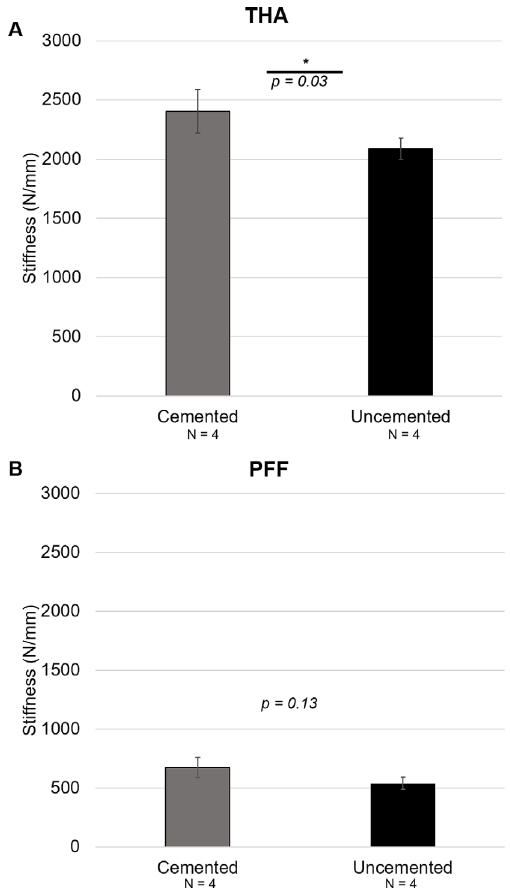
Figure 2. Comparison of stiffness between Cemented and Unce- mented specimens based on the overall average in THA group (A) and PFF group (B). *denotes statistical difference between the two variables ( P <